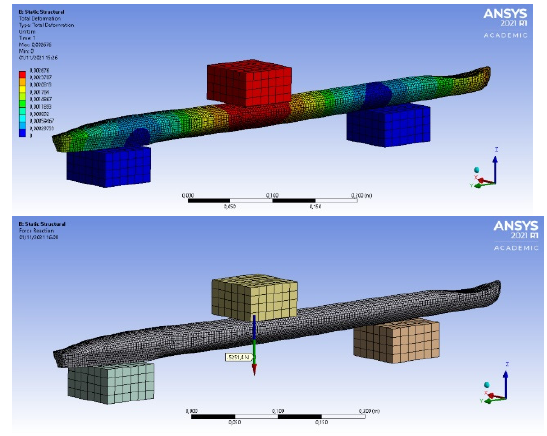
Figure 14. HexMC (displacement 2.55 mm, resulting force 5251.4 N) .